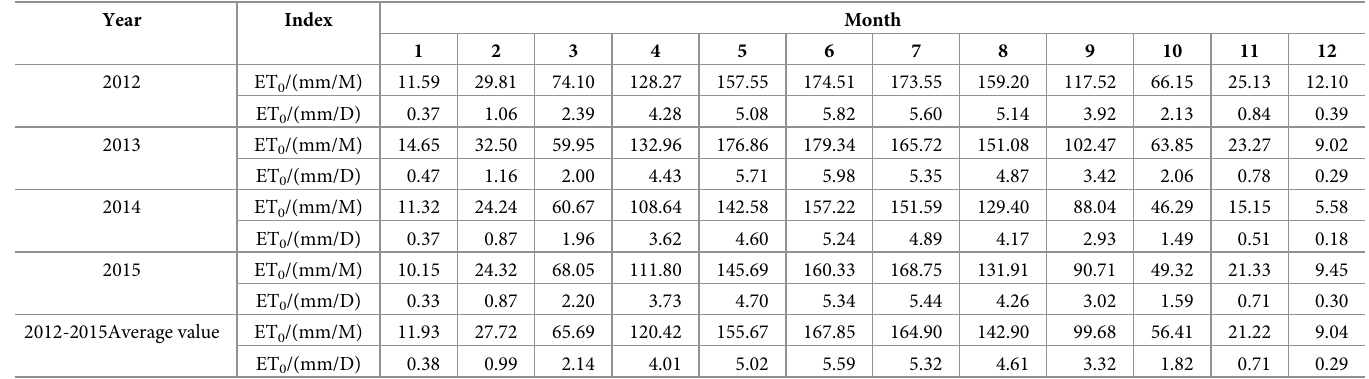
Table 1. Characteristic of reference crop evapotranspiration during 2012–2015. Year